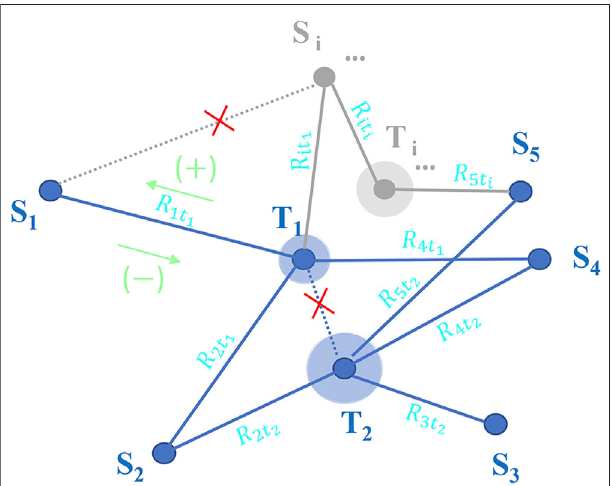
FIGURE 6 | Each stable state S refers to the stable polymerization state formed by the aggregation of ν s self-assembly monomers. Each transition state T refers to the Gibbs free energy maximum point on the transformation path. There is no direct linking between any two stable states or any two transition states. For each transition state, we add a disk to distinguish it from the stable state, and thesizeofthe diskisalso measured bythe relative Gibbs free energy. The R it refers the transformation rate of stable state S i via i transition state T i with the minus sign represents a decrease in concentration andtheplussignrepresentsanincreaseinconcentration.Forthegeneralityof the theory, the potentialstablestates and transition states are marked in gray. The C s which refers the concentration of stable state S is counted by polymerization cluster. The C 0 refers the total analytical concentration of self- assembly monomer in whole system. TheG s and G t are Gibbs free energies i of the monomers in stable state S and transition state t i respectively. The Gibbs free energy of the free monomer state is set as the zero point of whole energy